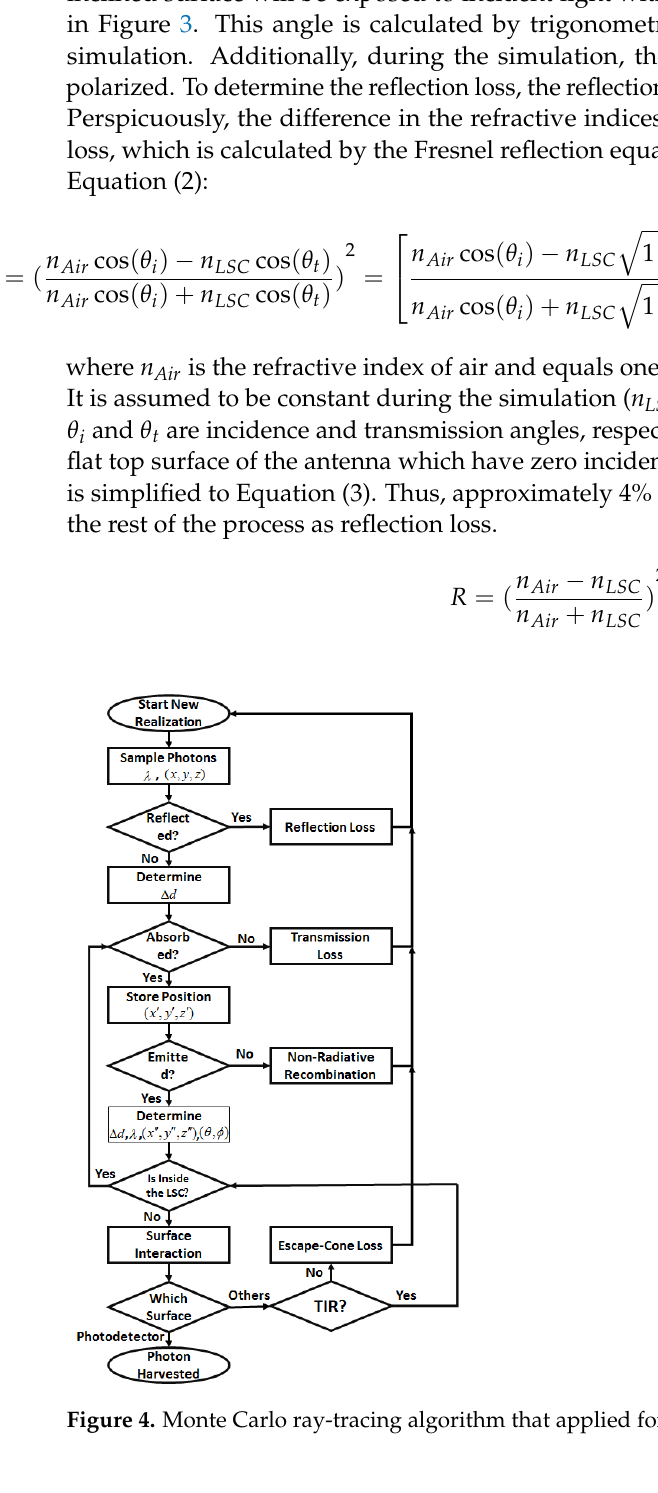
( a ) ( b ) Figure 5. ( a ) Probability density function (PDF) for white LED. It is directly generated from the emission spectrum of white LED (the only difference is its normalization to the area of the curve). ( b ) Cumulative density function (CDF) for white LED adapted from its PDF curve. Then, it should be clear whether the QDs absorb the photon or not. For a single photon, initially, it should be investigated which type of QD (type A, B, or C) may absorb the photon. A QD must have these conditions to have a chance to absorb the photon: firstly, the photon’s wavelength must be valid within the absorption range of the QD. Secondly, in that specific wavelength, the QD must have the largest absorption coeffi- cient (based on the absorption spectrum which is shown in Figure 2a–c). Next, the Beer–Lambert law determines the probability of a photon being absorbed after moving along a distance, Δ d (in cm) [52]: